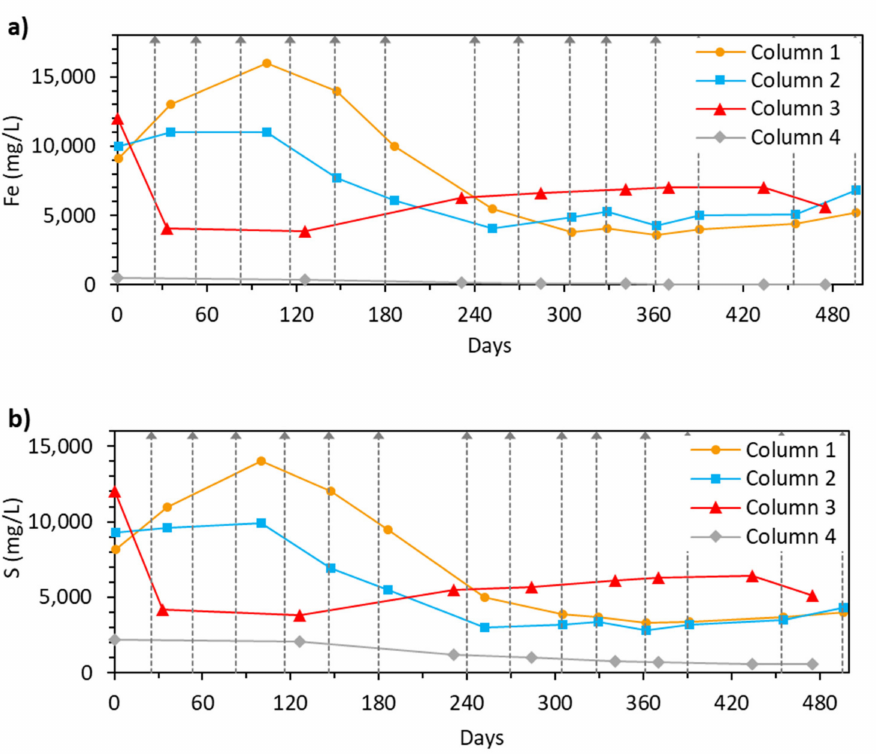
Figure 8. Concentrations of ( a ) total Fe and ( b ) total S in the column leachates. Vertical dashed lines mark the beginning of each wetting-drying cycle.